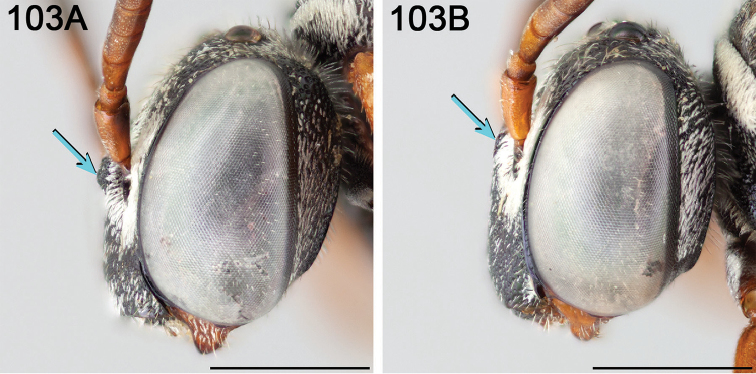
Head (in lateral view) of female A
E.
australis, in which the frontal keel is strongly raised, and B
E.
brumleyi paratype, in which the frontal keel is only weakly protuberant. Scale bars 1 mm. Note that the supraclypeal area is usually covered in dense white tomentum, which was partially removed in these specimens to show the maximum extent of the keel.